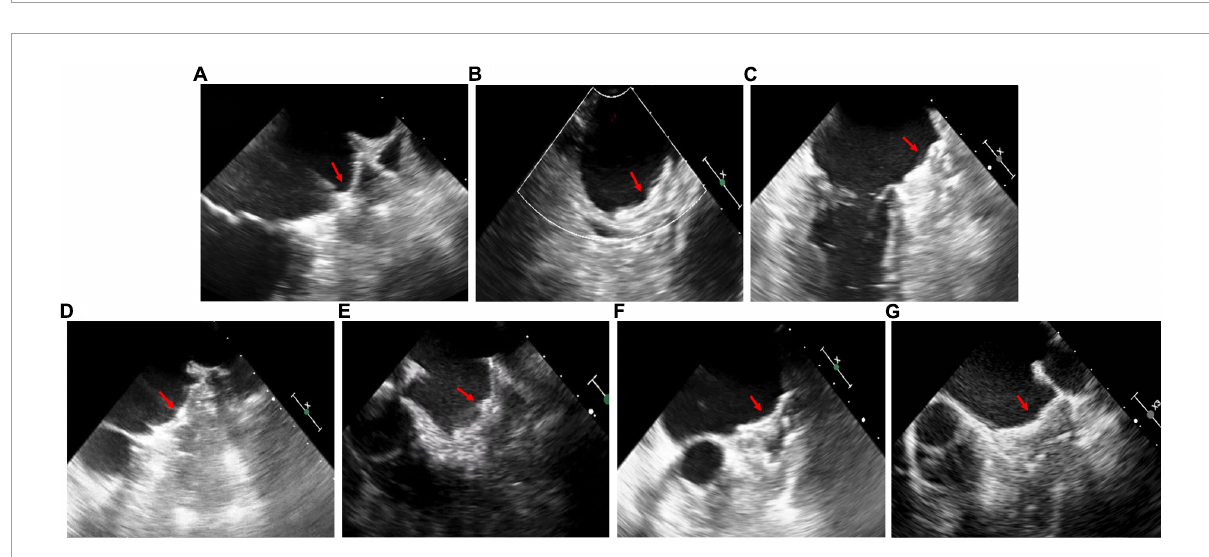
FIGURE3 Transesophageal echocardiography images in patient (A–G) after left atrial appendage closure. The red arrows point to devices.